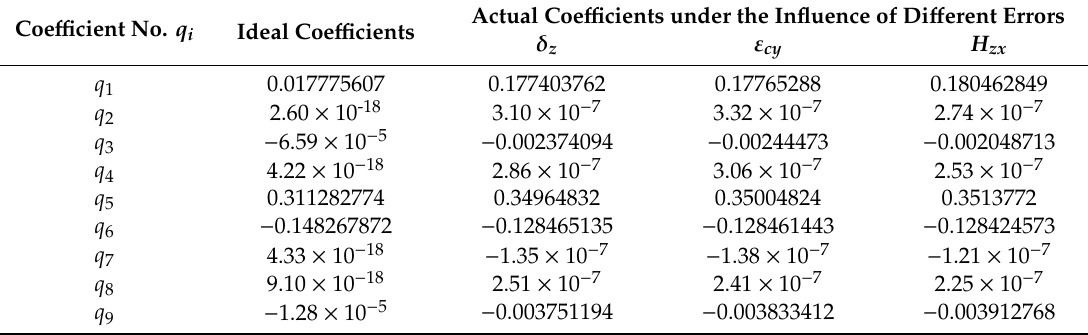
Table 4. Zernike fitting coe ffi cients of the wavefront of machined toric surface under di ff erent conditions. Coe ffi cient No. q i Ideal Coe ffi